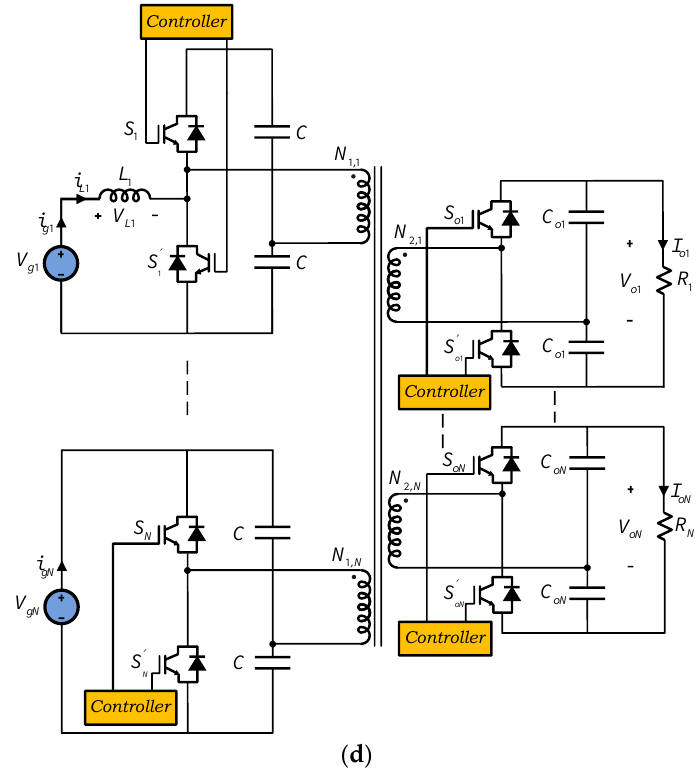
Figure 11. MIMO isolated. ( a ) Boost parallel converter. ( b ) Boost ports converter. ( c ) Half-Bridge converter. ( d ) Boost – Half-Bridge converter combination. Table 7. Comparative summary of MIMO DC – DC Converters Isolated.